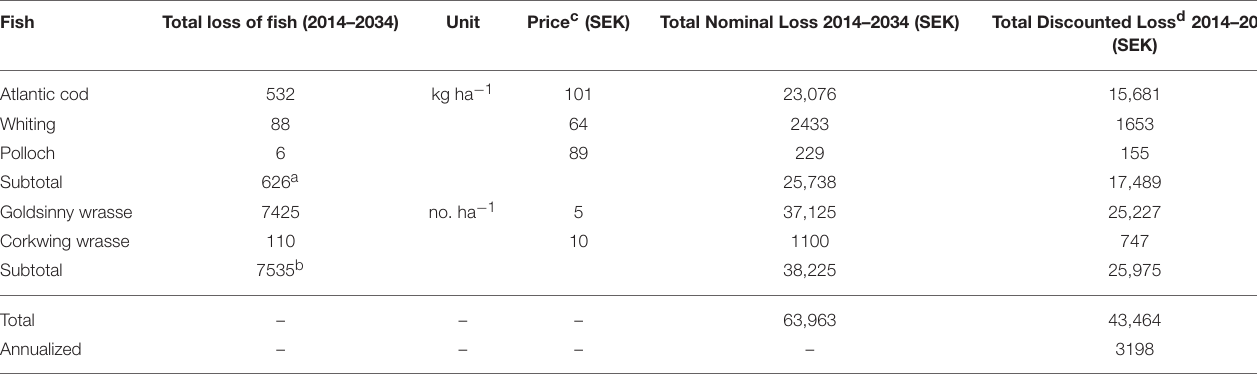
TABLE 4 | Estimating per hectare value of eelgrass—Commercial Fish Production. Fish